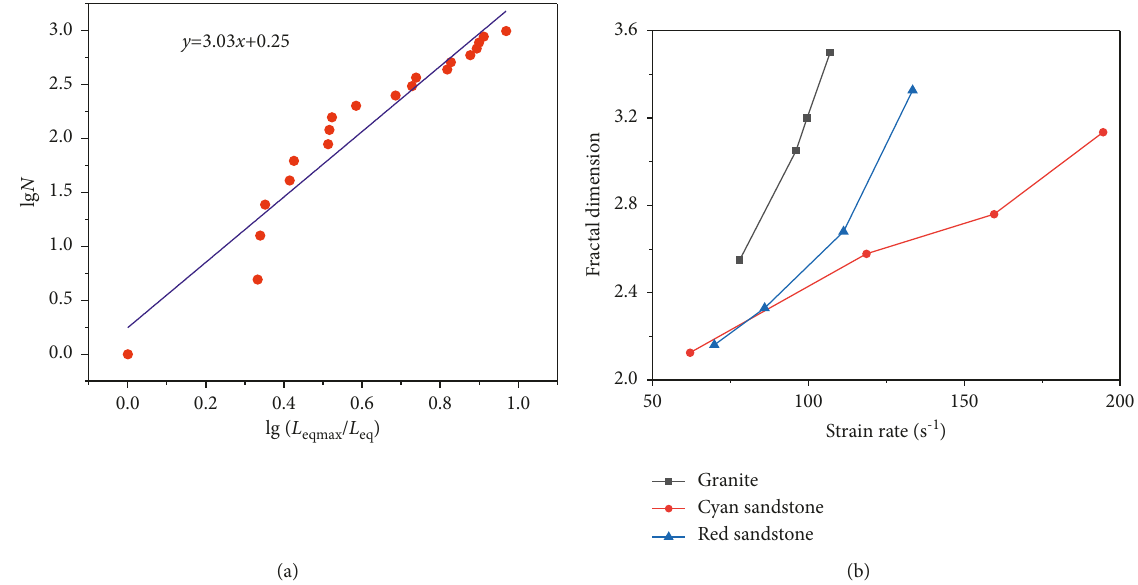
Figure 11: (a) Diagram of FD calculation and (b) variations of the FD with the strain rate.